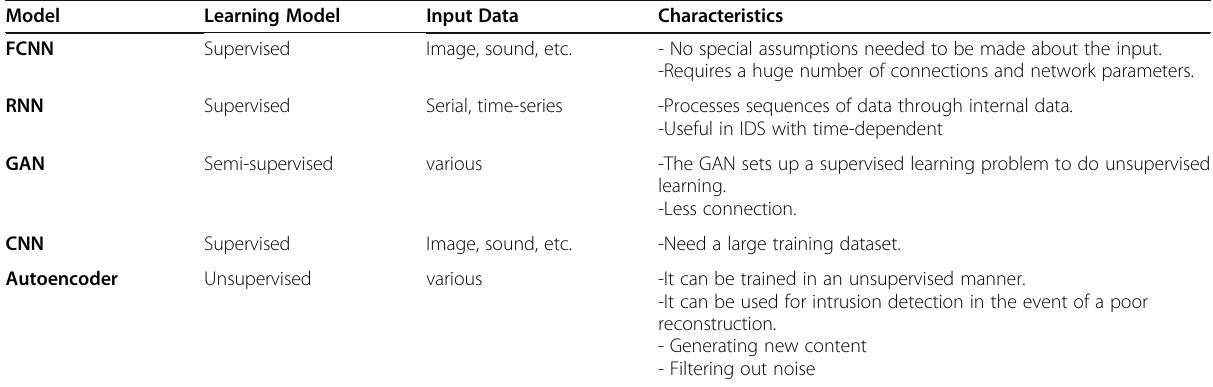
Table 5 Summary of deep learning model techniques